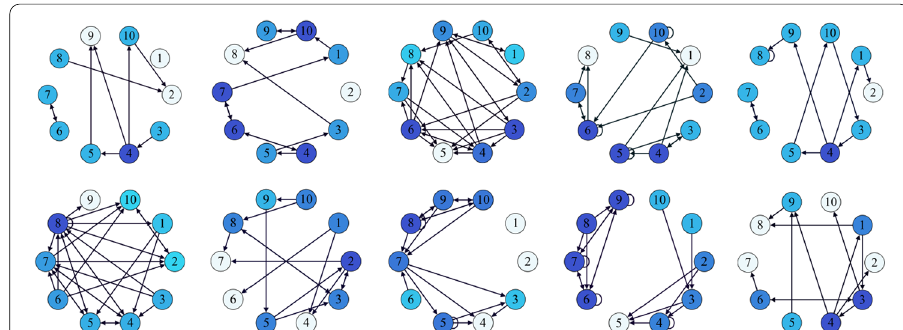
Fig. 1 Graphs of 10 daily lead–lag networks